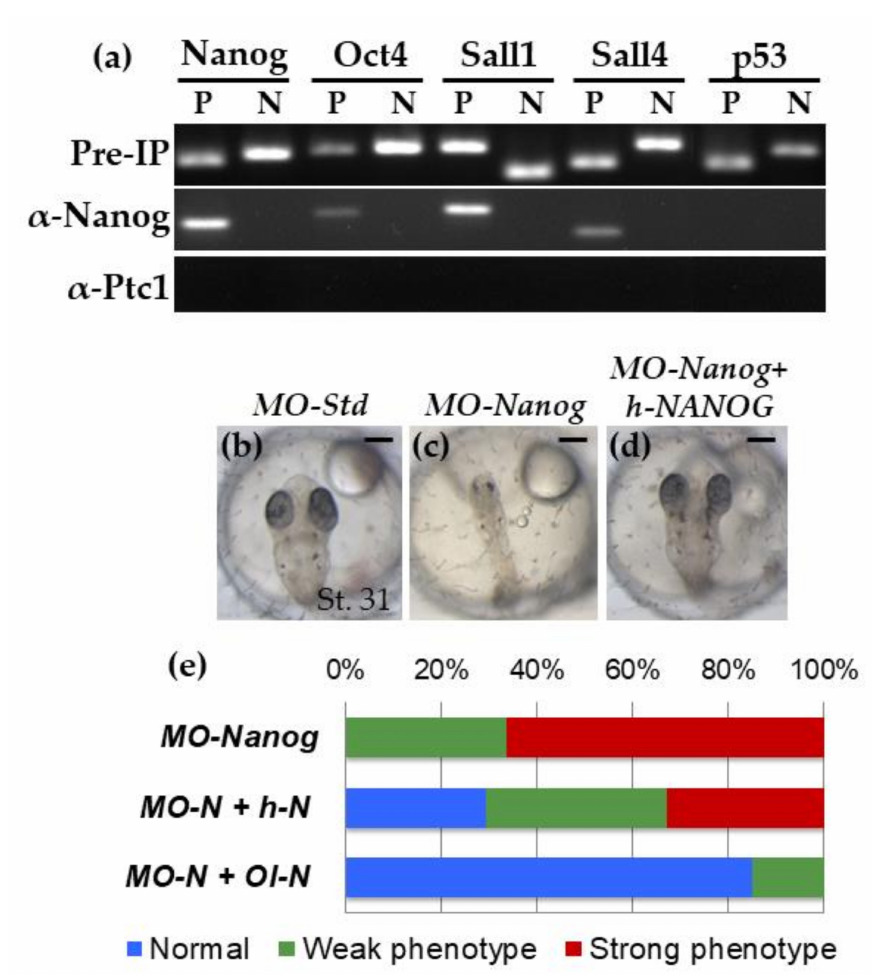
Figure 1. Ol-Nanog is functionally equivalent to human NANOG. ( a ) Nanog transcription factor binds to some genes at their promoters in medaka as it does in mESC. ChIP assay using the Ol-Nanog antibody. To determine the promoter sequences of the genes the conservation analysis was made using the genome sequences of Medaka, Stickleback, Tetraodon, Fugu, and Zebrafish. ChIP was performed with antibodies for Ol-Nanog, and Ol-Ptc1 as negative control. PCR reactions were performed before (pre-IP; positive control) and after ChIP. Abbreviations: Anti-Ptc1, Anti-Patched1; Pre-IP, pre-immunoprecipitation, P: regulatory region of the gene, N: sequence outside the regulatory region of the gene. ( b – e ) Ol-Nanog and h-NANOG rescue the abnormal phenotype provoked by MO-Nanog. ( b – d ) Pictures showing stage 31 embryos after injection in one cell stage of MO-Std as a MO control ( b ), MO-Nanog ( c ) and MO-Nanog+h-NANOG mRNA ( d ). While 100% of embryos injected with MO-Nanog that survive to stage 31 had small size and abnormal development of the head and trunk structures, 29.4% of embryos injected with MO-Nanog + h-NANOG showed